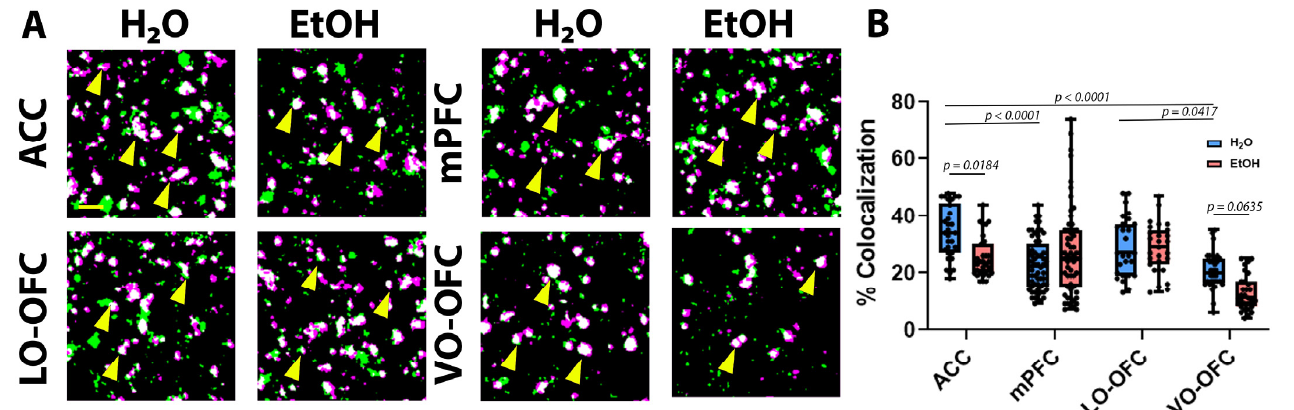
Figure 6. The effect of AIE on neurexin-neuroligin 3 interactions after a 26-day forced abstinence period. We found that AIE did not change neurexin or neuroligin 3 expression following a 26-day forced abstinence period (see supplemental data). ( A ) Representative images of neurexin (green) and neuroligin 3 (magenta) in the ACC, mPFC (IL and PL), LO-OFC, and VO-OFC. Scale bar, 2 µ m. ( B ) Quantification of neurexin and neuroligin 3 co-localization. There was a significant decrease in neurexin-neuroligin 3 co-localization in the ACC ( p = 0.0184) and the VO-OFC ( p = 0.0635). Data presented as box and whisker plots with interquartile range with mean, minimum, and maximum measures indicated along with individual data points. Three 5 µ m image stacks from randomly selected hemispheres were captured from 3 separate brain slices per animal (n = 9–10 brains/treatment group). Analysis: two-way ANOVA with Tukey’s post hoc